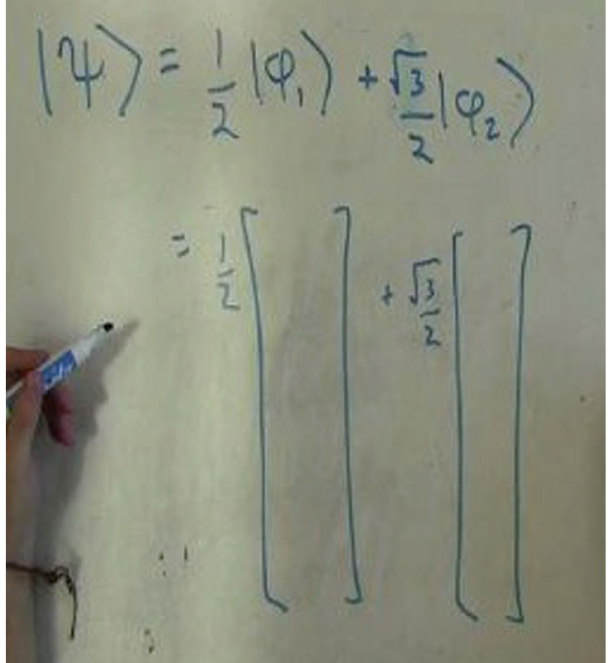
FIG. 1. Prompted to represent the state in matrix notation, Carlton begins by writing an expression in Dirac notation, then writing a parallel expression with column vectors in place of